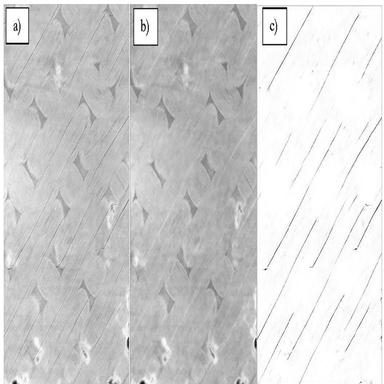
−45° cracks crack segmentation. a) Initial image b) Closing result and c) Subtraction result between the images in a) and b).